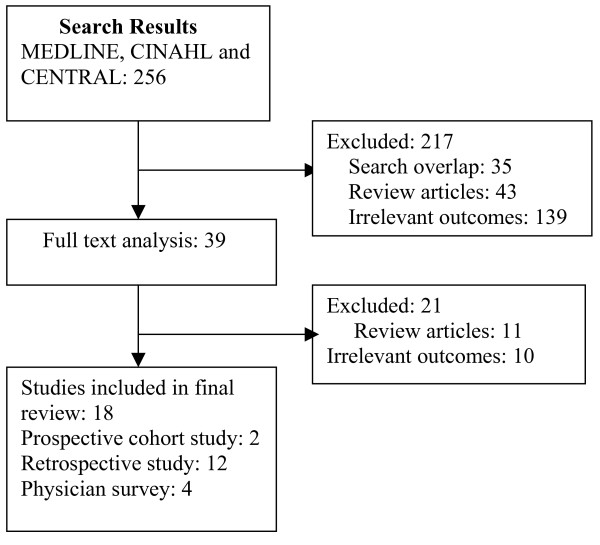
Flow chart showing the search, the major reason for exclusions of studies and the final number of studies included in this review.